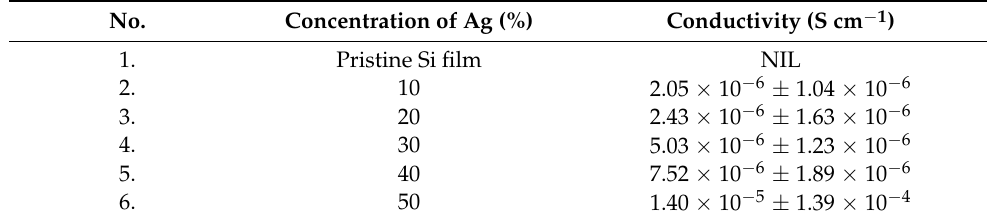
Table 2. Conductivity measurement of Si–Ag thin